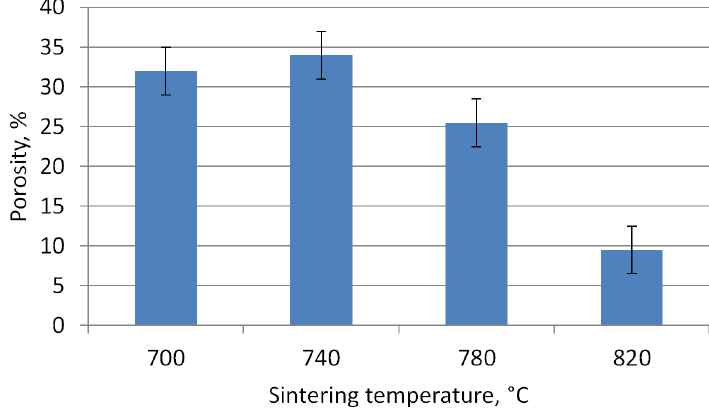
Figure 5. The effect of sintering temperature on porosity of the metallic binders.